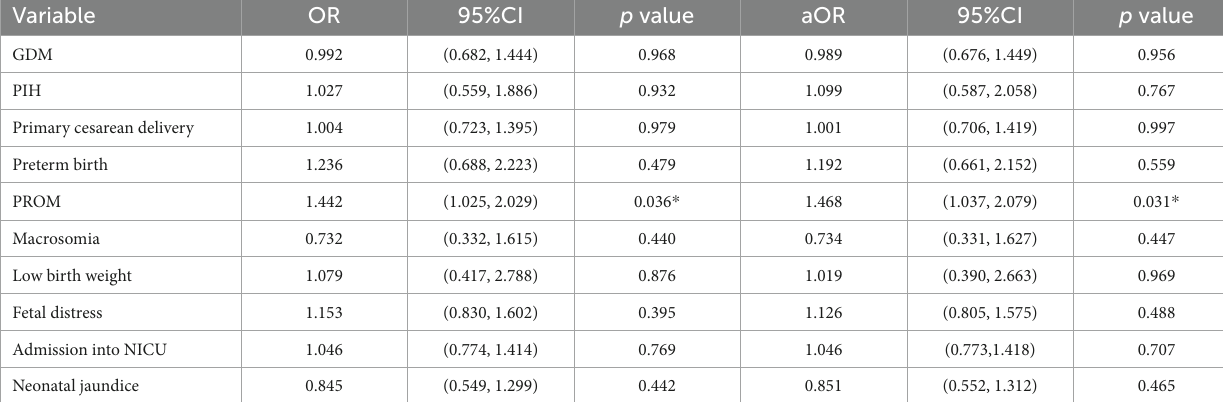
TABLE 3 Correlation between maternal second-trimester stress and pregnancy complications and pregnancy outcomes.